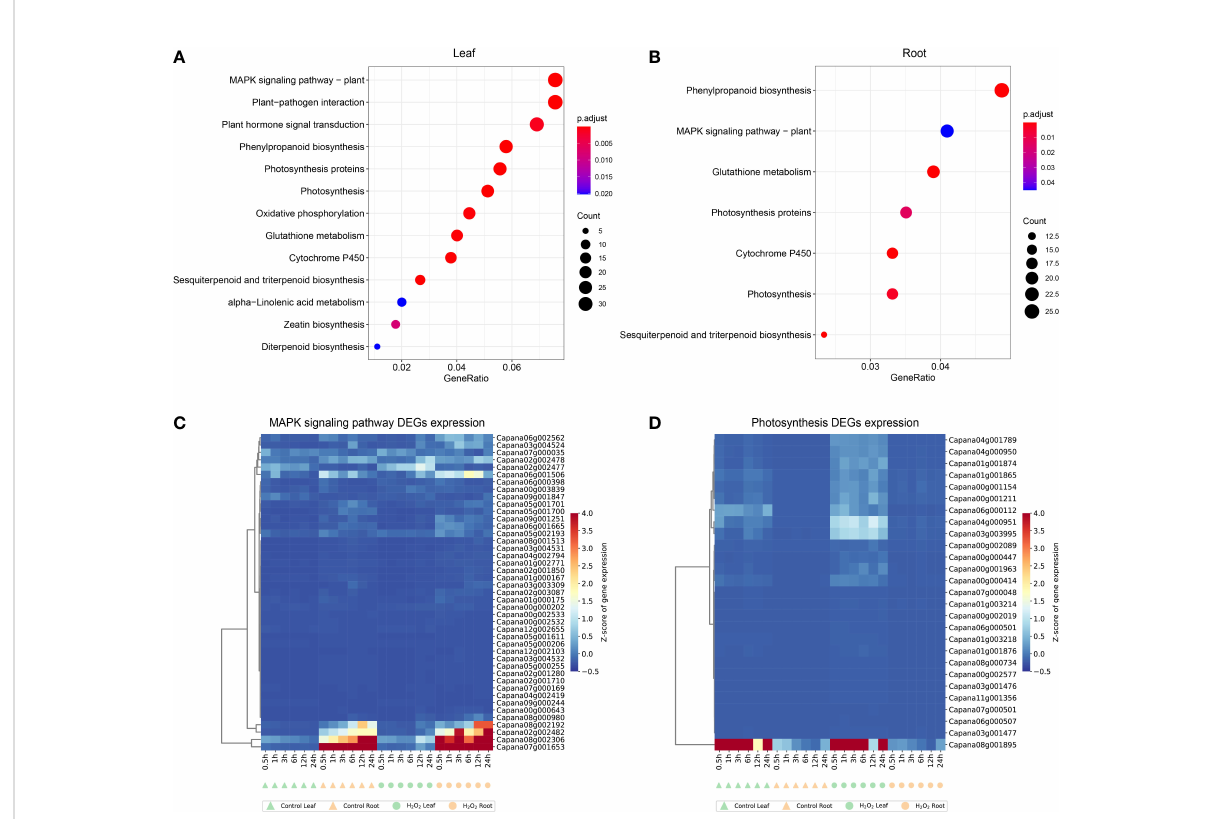
FIGURE 5 Kyoto encyclopedia of genes and genomes (KEGG) pathway enrichment analysis results for the DEGs in leaf (A) and root (B) . Expression pro fi les of DEGs enriched in MAPK-signaling pathway (C) and photosynthesis pathway (D) in leaves and roots. The complete list of DEGs and KEGG pathways for enrichment analysis is shown in Supplementary Tables S6,